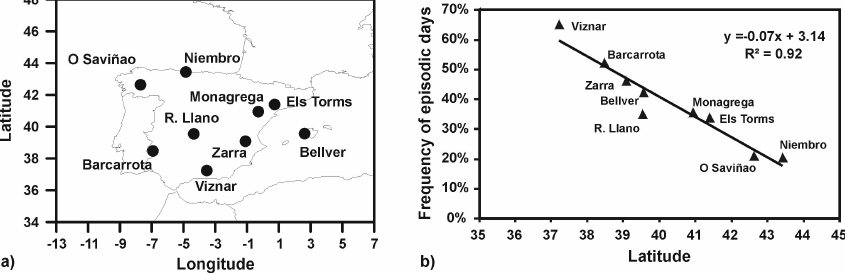
Figure 1. Location of regional background air quality monitoring sites used in this study (a) and relationship between their latitudes and the frequency of episodic days registered at them (b)